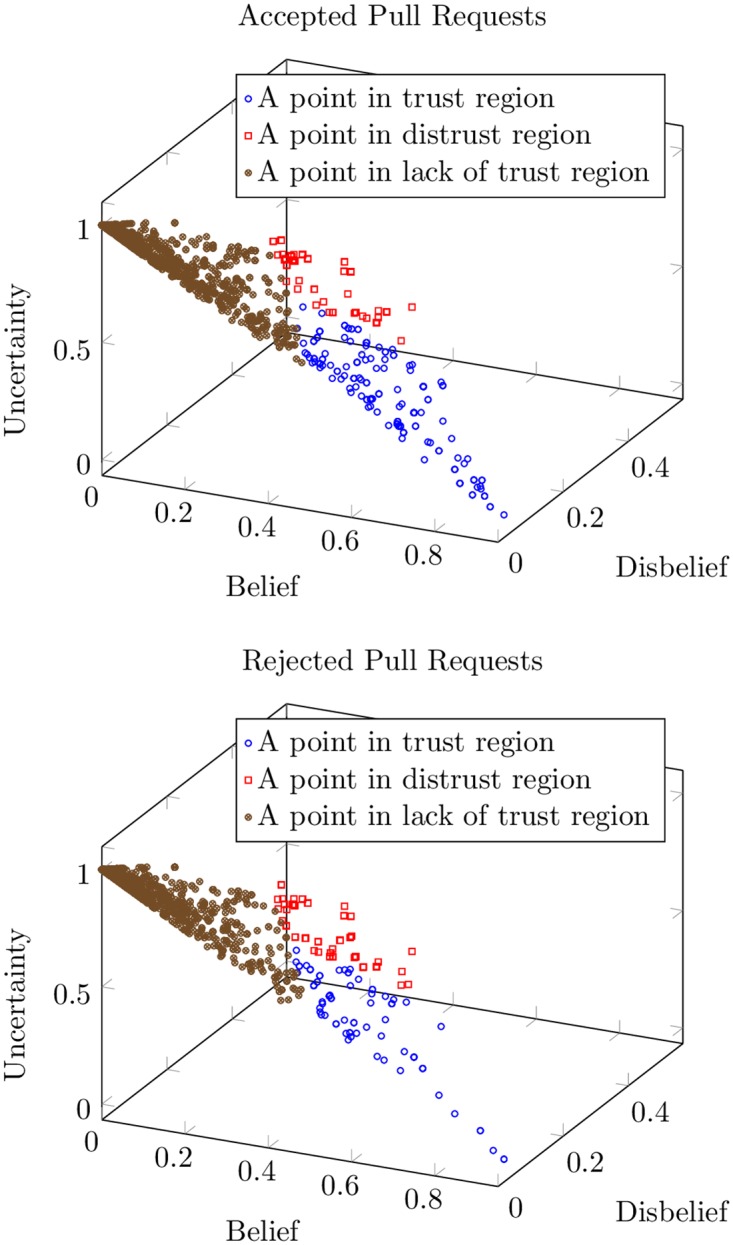
3D plots showing a joint comparison of trust dimensions (belief, disbelief, and uncertainty) between accepted and rejected pull requests.The pull requests in the regions of trust, distrust, and lack of trust are shown as data points in blue, red, and brown, respectively.